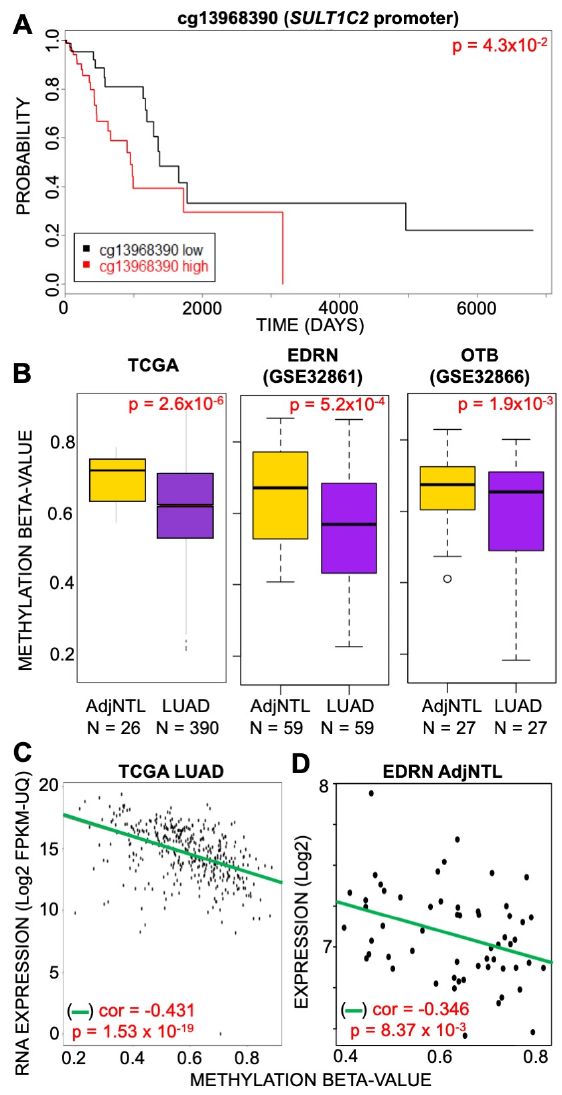
Figure 2. Methylation of SULT1C2 promoter is altered in human lung. ( A ) Overall patient survival (OS) for samples from the TCGA dataset was split by upper quartile based on methylation at cg13968390 using TCGAbiolinks [43]. ( B ) Boxplots of methylation at cg13968390 derived from TCGA (left), EDRN (middle), and OTB (right) datasets. N = number of samples in collection included in calculations. An unpaired t -test was used on TCGA data as the AdjNTL samples are derived from non-matched individuals in that dataset. Paired t -tests were used for EDRN and OTB datasets as their AdjNTL was derived from the same patient as the LUAD tumor tissues. Yellow = AdjNTL, purple = LUAD. ( C ) Correlation between expression and methylation in TCGA LUAD tumors (correlation = − 0.431, p = 1.53 × 30 − 19 ). ( D ) Correlation between expression (probe ILMN_1772148) and methylation (cg13968390) from the EDRN AdjNTL